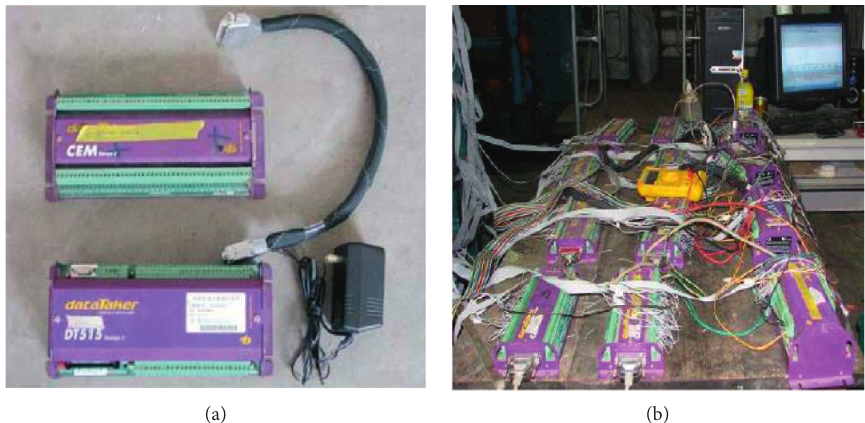
Figure 11: The effect of each factor on the roadway stability in the similar material simulation experiment.